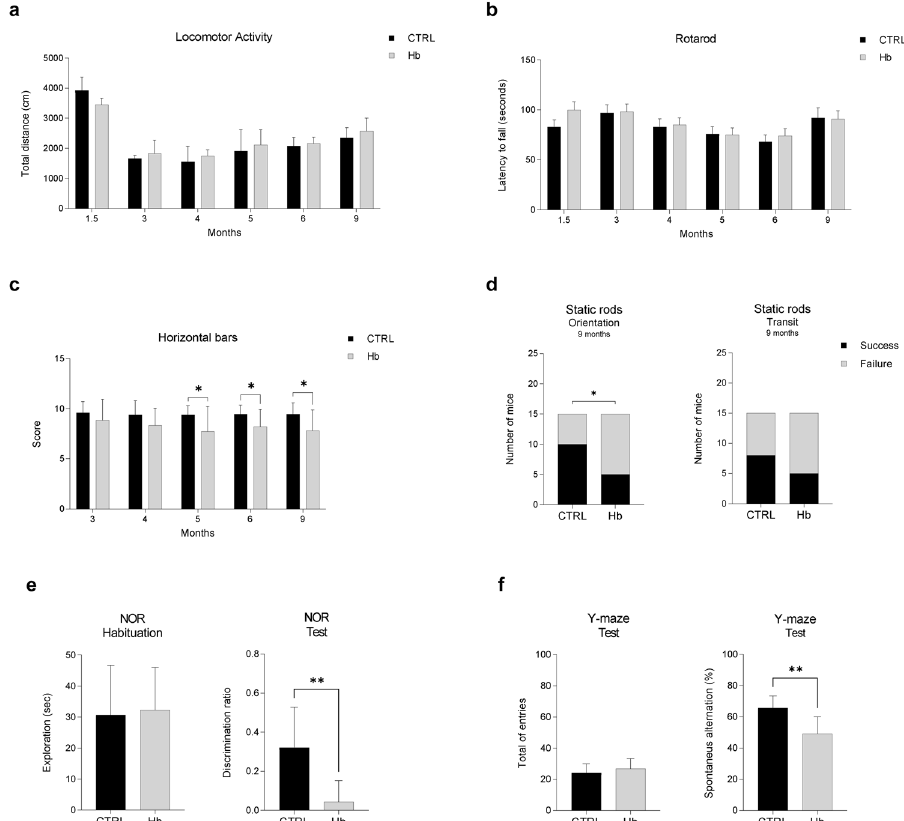
Fig. 2 Hb overexpression in SNpc decrease motor performances and trigger cognitive impairments. CTRL ( n = 12) and Hb ( n = 12) mice were assessed for locomotor activity and total distance (cm) was recorded at different time points after injections ( a ). CTRL ( n = 15) and Hb ( n = 15) mice were also scored for motor coordination with the rotarod test ( b ) and latency to fall was measured. Horizontal bars test was used to assess forelimb strength and coordination and CTRL ( n = 15) and Hb ( n = 15) mice were scored for their performance( c ). Data represent means ± SEM. Statistical analysis was performed with unpaired t-test with Welch ’ s correction. * p ≤ 0.05. CTRL ( n = 15) and Hb ( n = 15) were assessed in static rods test measuring two parameters, transit time and orientation time (seconds) and different time points. In panel ( d ) it is depicted the results at 9 months after injection. Chi-square test was used to evaluate the success/failure of each group. * p ≤ 0.05. Novel object recognition test (NOR) was used to evaluate recognition memory ( e ). CTRL ( n = 8) and Hb ( n = 8) was habituated to the object for 10 min and exploration (seconds) of the objects was measured ( e left panel). After 1 h, mice were assessed to recognize the novel object and the discrimination ratio was plotted ( e right panel). Spontaneous alternation in the Y-maze was used to measure spatial working memory in CTRL (n = 10) and Hb ( n = 12) mice ( f ). Total entries were calculated for each group ( f left panel). Spontaneous alternation % was plotted for each group ( f right panel). Data represent means ± SEM. Statistical analysis was performed with unpaired t-test with Welch ’ s correction. * p ≤ 0.05; ** p ≤